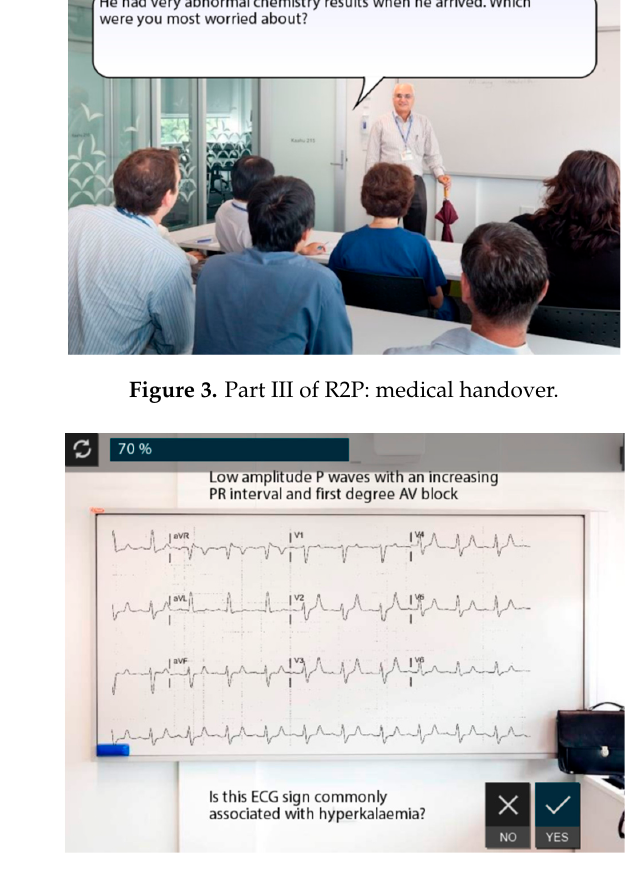
Figure 4. Part III of R2P: identifying ECG changes.